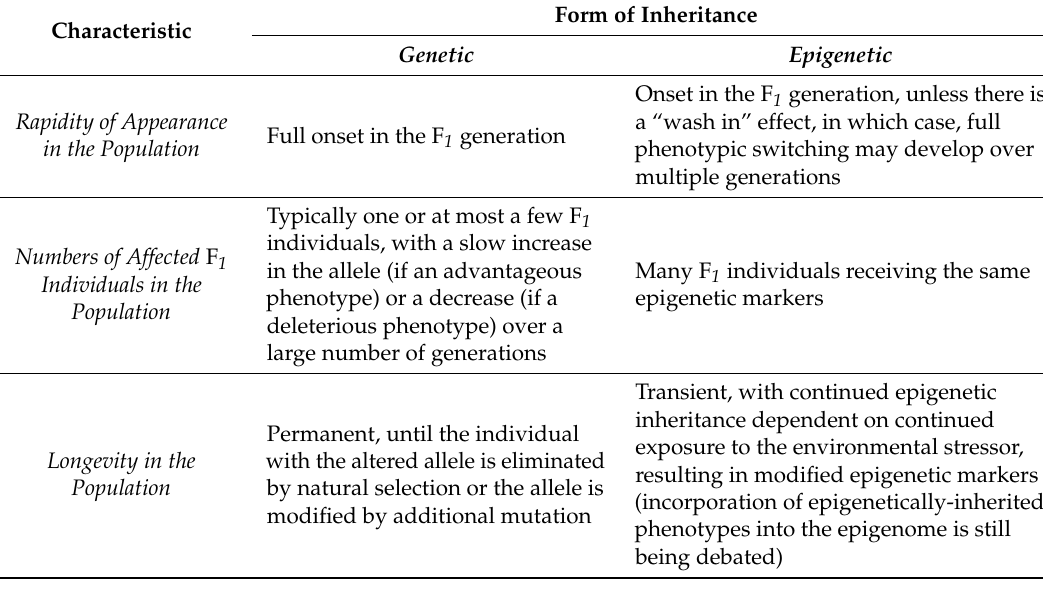
Table 1. A comparison/contrast of the timing and reach of genetic and epigenetic